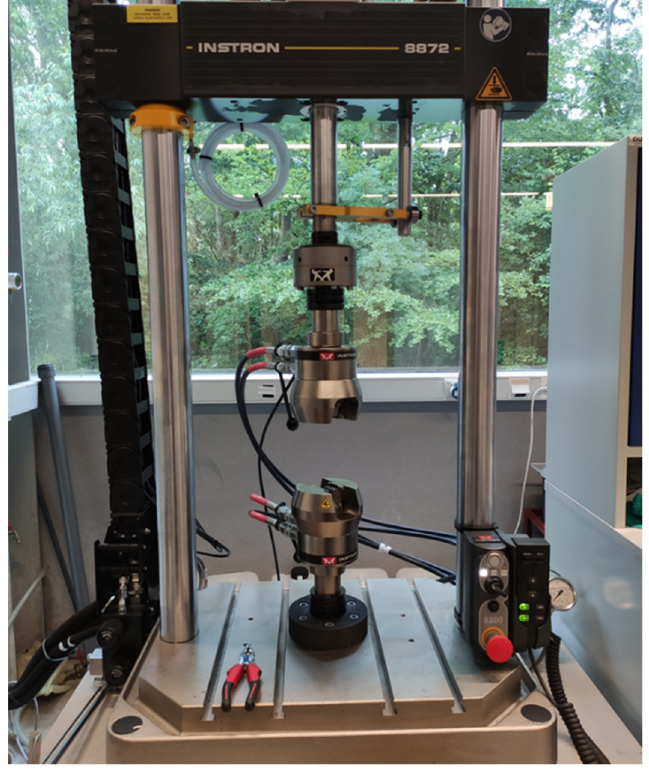
Figure 3. Tensile test machine Instron 8872.